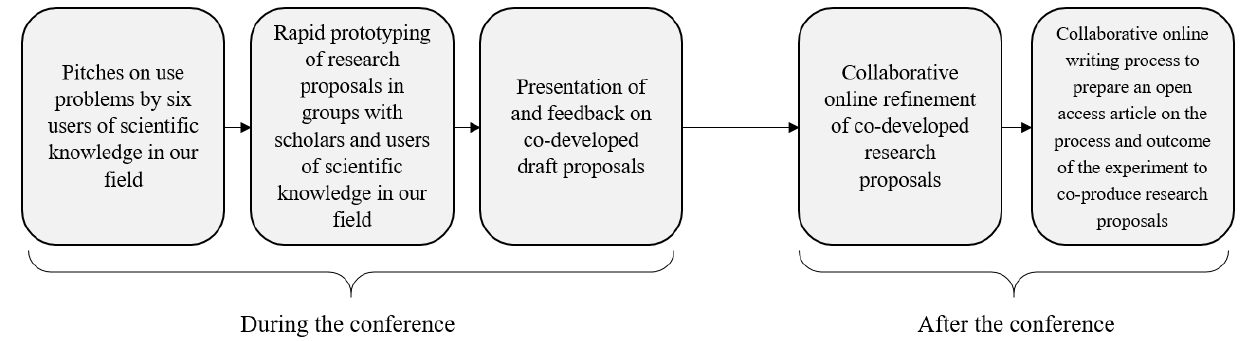
Fig. 1. Illustration of the process used to co-develop research